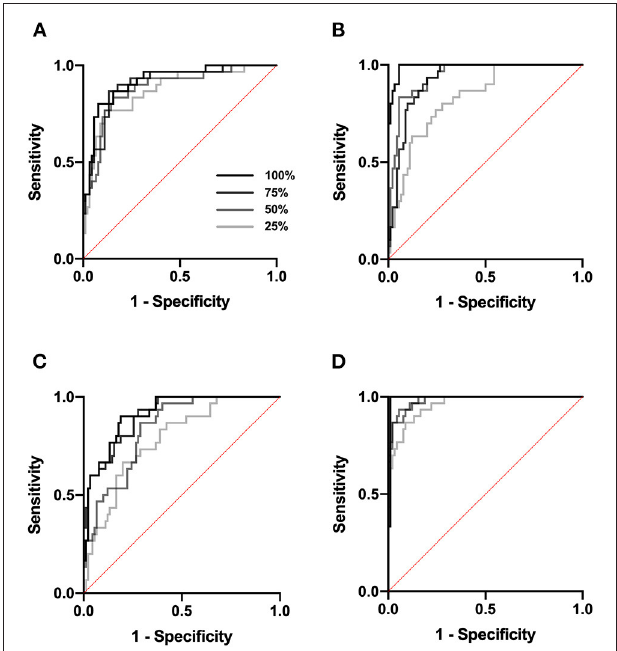
FIGURE 3 | AUC values as a function of the sample size. The AUC of ROC analysis was shown at a sample size of 25, 50, 75, and 100%. (A) for atelectasis. (B) for pleural effusion. (C) for pneumonia. (D) for no